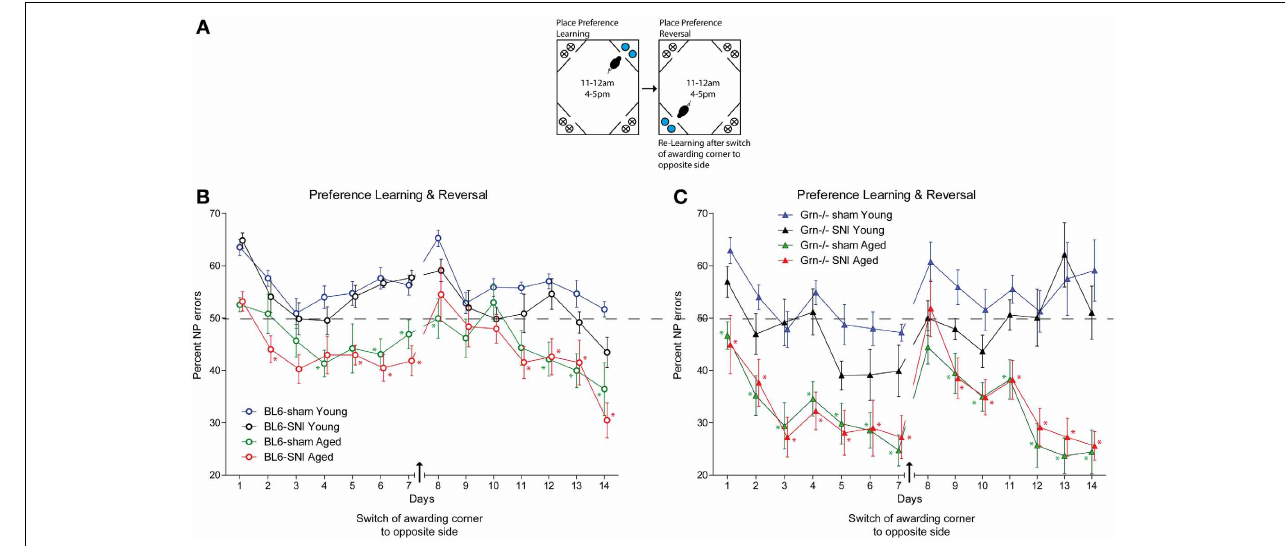
FIGURE 5 | Place “preference learning” and “reversed place preference learning” in young and aged C57BL6/J and progranulin deficient (Grn − / − ) mice. (A) Illustration of the place preference learning and reversal tasks. The blue circles indicate nosepokes where a water award was provided. The crossed circles show non-awarding nosepokes, i.e., water access was blocked, without punishment. (B,C) Time courses of nosepoke